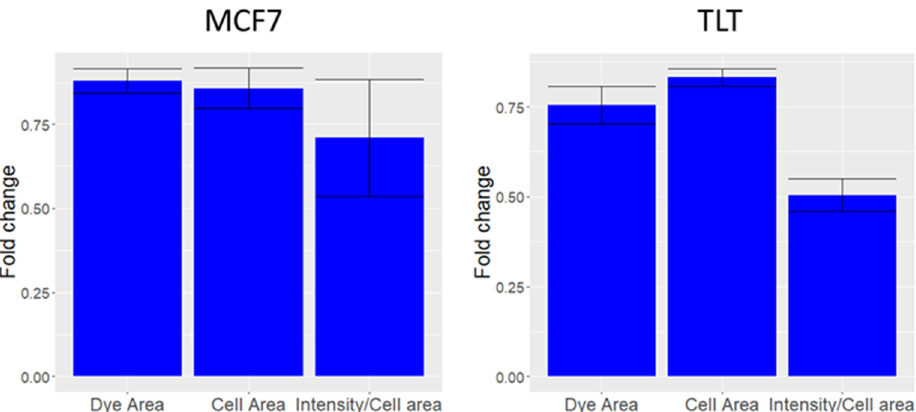
Figure 6. The effect of Triton x20 on MCF7 and TLT cells. ( MCF7 ) The change in area covered by the dye (Dye area), area of the cell (Cell area), and compensated intensity (total FV intensity/Dye Area) of MCF7 cells treated with Triton TM X-100 with respect to untreated MCF7 cells. ( TLT ) The same procedure was applied to the TLT cell line.